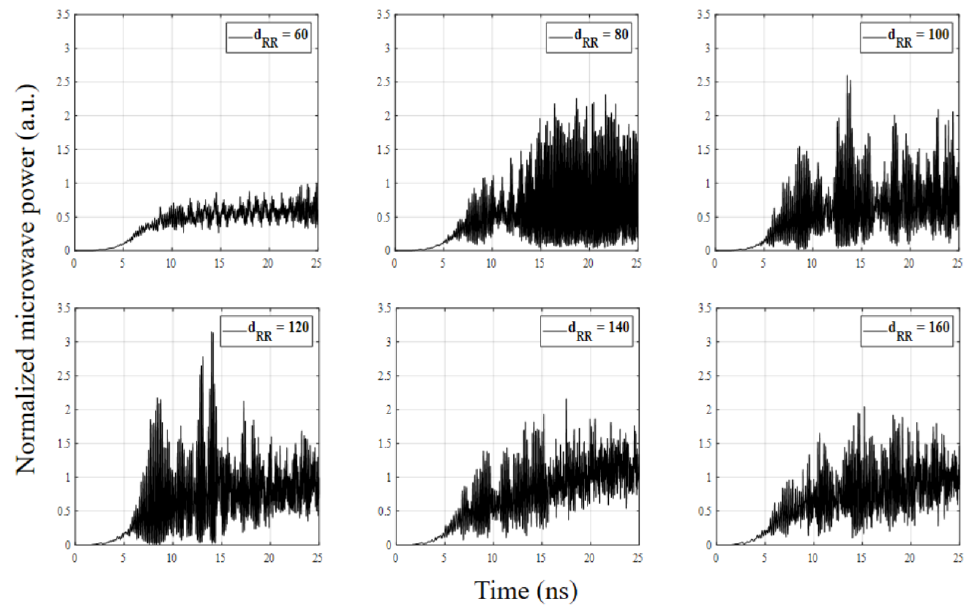
Figure 5. Normalized microwave power of the axial vircator with and without the ring reflector.